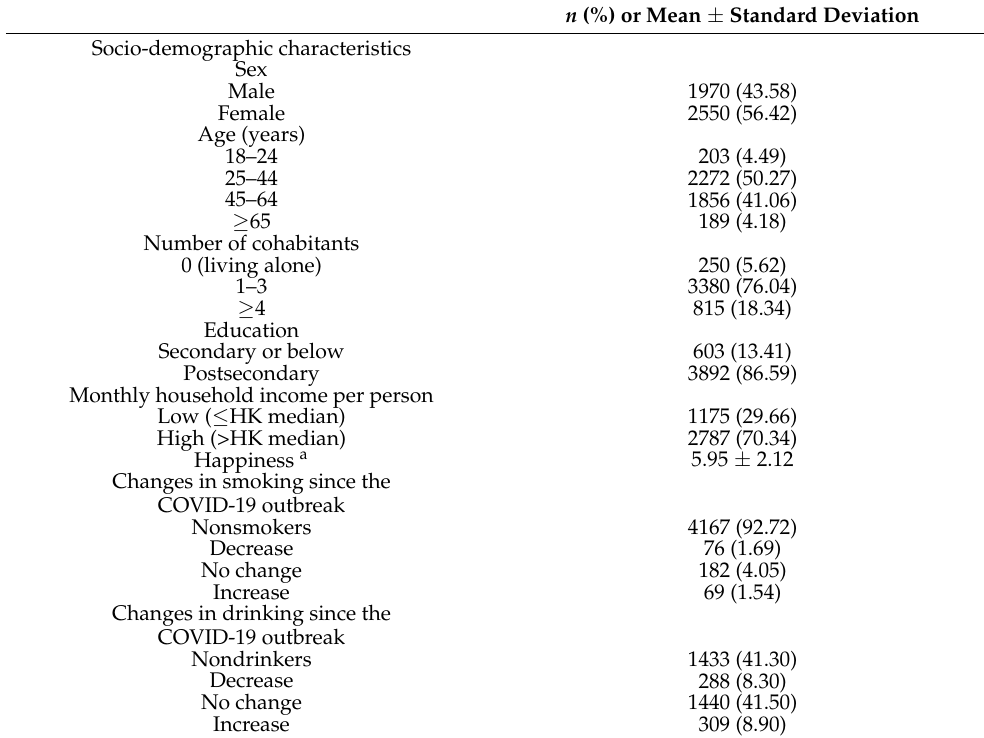
Table 1. The characteristics of the study sample, unweighted (N =